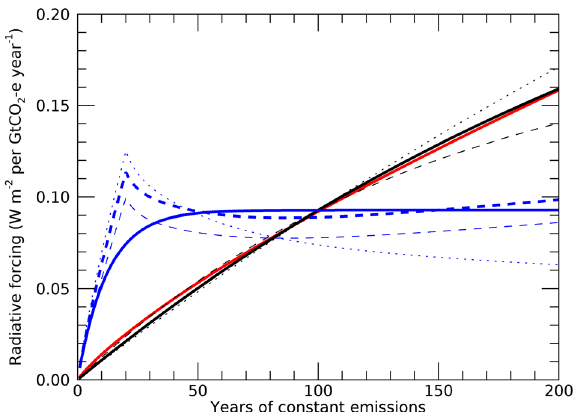
Fig. 1 Radiative forcing due to constant 1 GtCO 2 per year CO 2 emissions (red) and 1 GtCO 2 -e per year (using GWP 100 ) methane emissions (blue solid line) calculated using Absolute Global Warming Potentials given in AR5. Black lines show exponential approximation to the CO 2 forcing with s = 0.25 (solid), s = 0.143 (dotted) and s = 0.4 (dashed), implying a forcing decay rate ρ of 0.33%, 0.167% and 0.67% per year, respectively, for zero CO 2 emissions. This exponential decay rate in forcing is equivalent to assuming a simple exponential decay of CO 2 emissions following a pulse emission, a simpli fi cation of the linear CO 2 decay model used in AR5 6 , focussing on intermediate timescales. Thick blue dashed line shows forcing due to CO 2 warming-equivalent emissions calculated using the coef fi cients provided in this note (4.53 GtCO 2 per year for 20 years, followed by 0.28 GtCO 2 per year), while thin dashed and dotted lines show, respectively, corresponding forcing using coef fi cients provided in Cain et al. (2019) (4 GtCO 2 per year for 20 years, followed by 0.25 GtCO 2 per year) and Allen et al. (2018) (5 GtCO 2 for 20 years, followed by zero, corresponding to s = 0). Comparing the blue dashed lines show how including the factor g ( s ) > 1 increases the estimated forcing due to methane emissions relative to CO 2 under